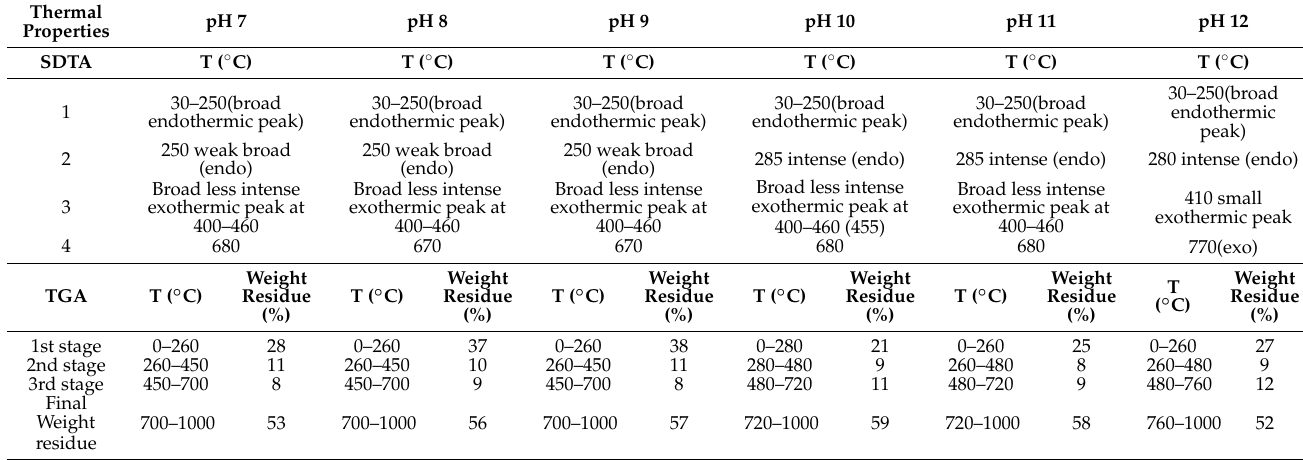
Table 3. XRD data for 2 θ value, d-spacing, and FWHM for PPVA-AlPO 4 nanocomposite samples at different pH values (7–12).